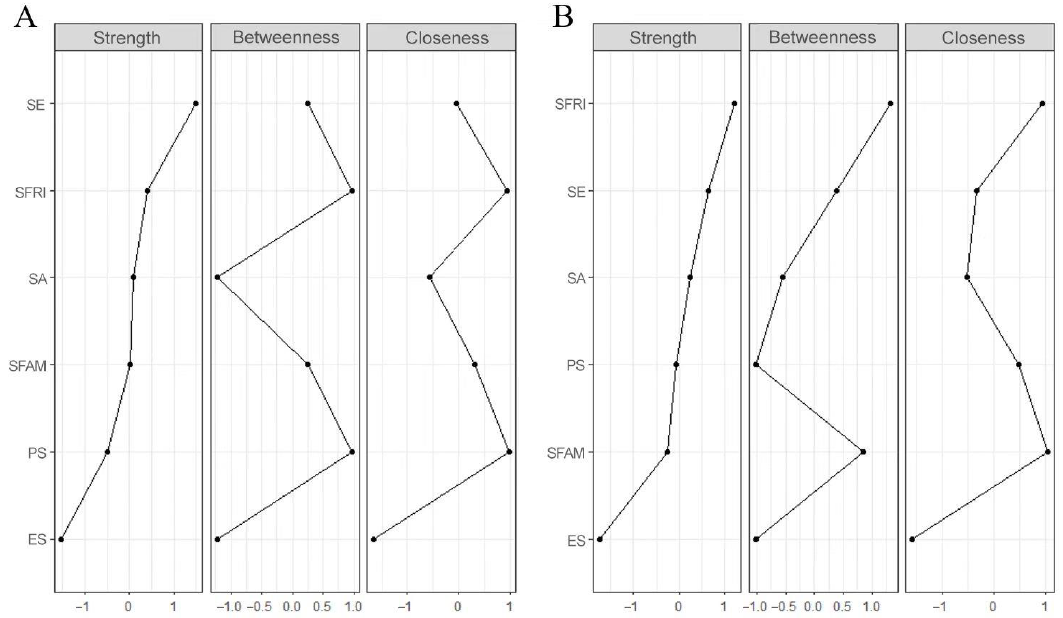
Figure 3. Centrality measures of all symptoms within the network. Note, the figure shows the centrality measure (i.e., strength, betweenness, and closeness) of all factors within the network (z-scores). ( A ), wave 1. ( B ), wave 2.